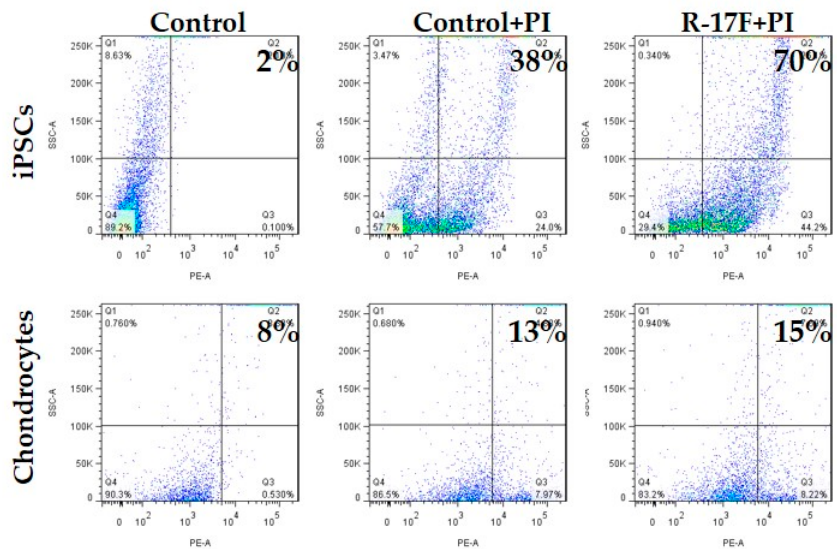
Figure 4. Evaluation of the cytotoxicity of R-17F against iPSCs and chondrocytes. Both iPSC (606A1) and chondrocyte (C28I2) cell lines were treated with R-17F, stained with PI, and analyzed by flow cytometry.